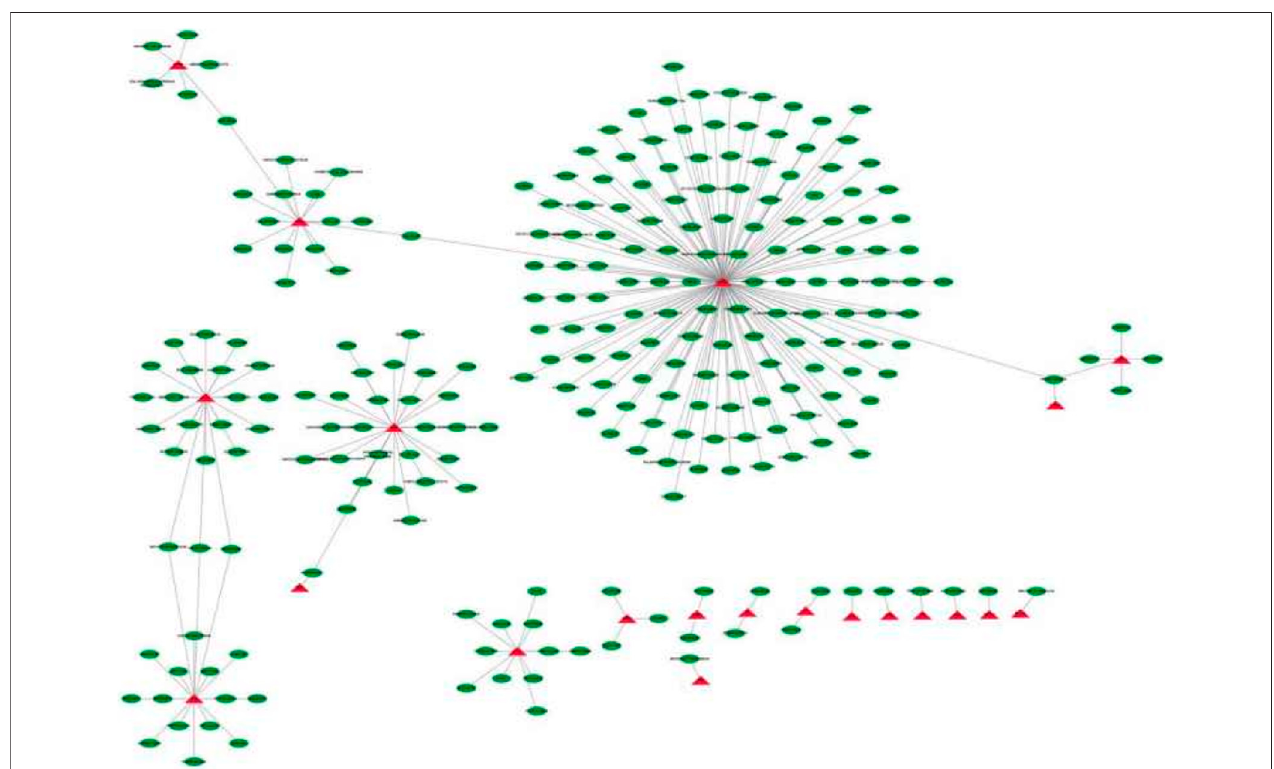
FIGURE 8 | Core gene-drug interaction network The red triangle is the core gene and the green ellipse is the drug molecule.